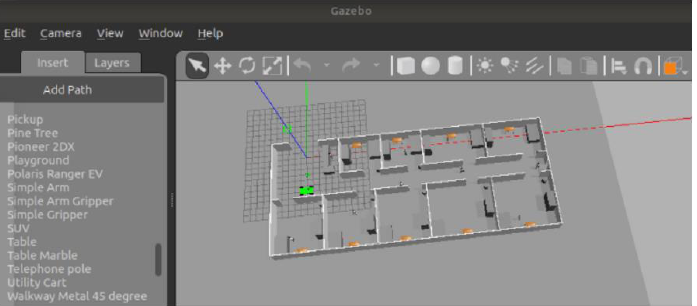
Figure 2. Gazebo main screen. Gazebo can run 3D robot simulations. ROS Visualization (RVIZ) is a 3D visualization tool for ROS applications; its main screen is shown in Figure 3. RVIZ displays the mobile robot model, captures robot sensor data, and reproduces the captured data. It can display data from cameras, lasers, and 3D and 2D devices as images and point clouds